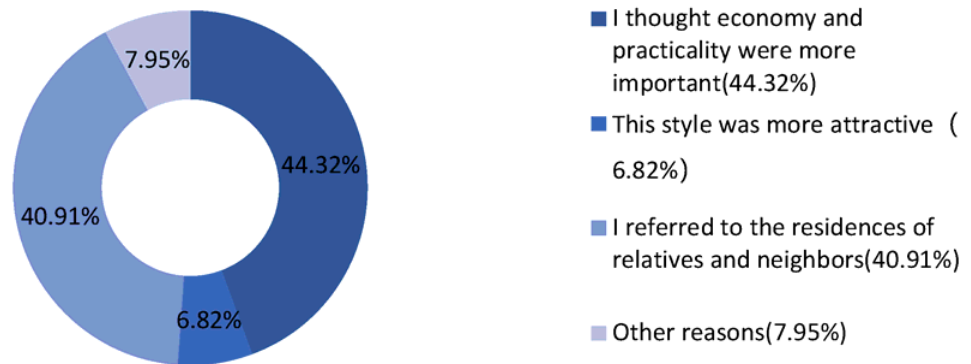
Figure 7. The reasons for not choosing the traditional roof. The original question was “Why did you choose the nontraditional roof?”.